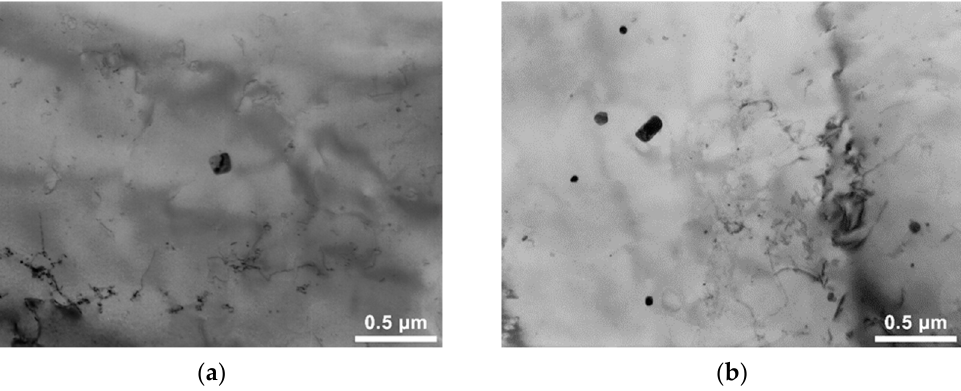
Figure 6. Submicron precipitates in samples of the batches (TEM, bright-field images): ( a ) No. 1-1; ( b ) No. 2-2.